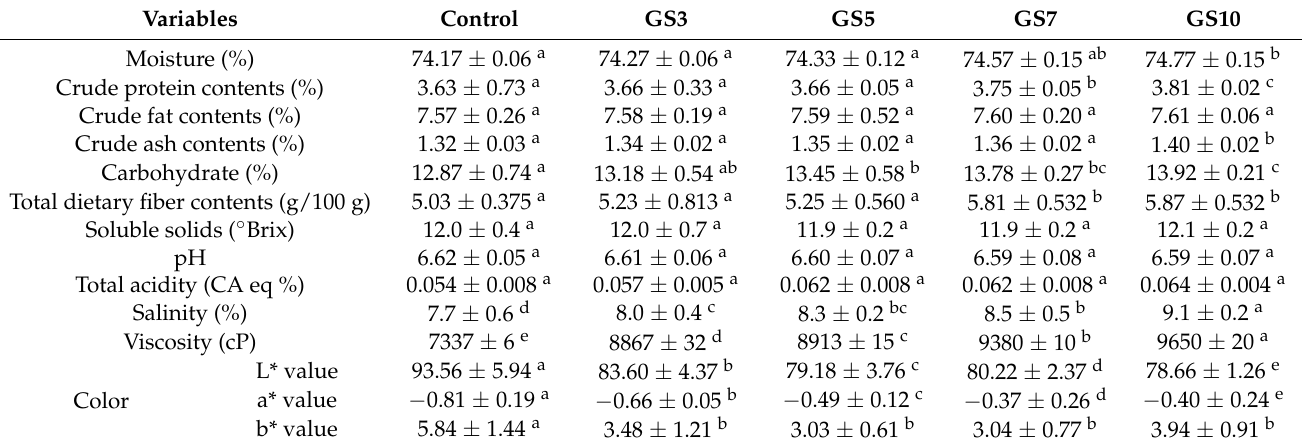
Table 1. Physicochemical, quality, and color analysis of cream soup supplemented with ginseng